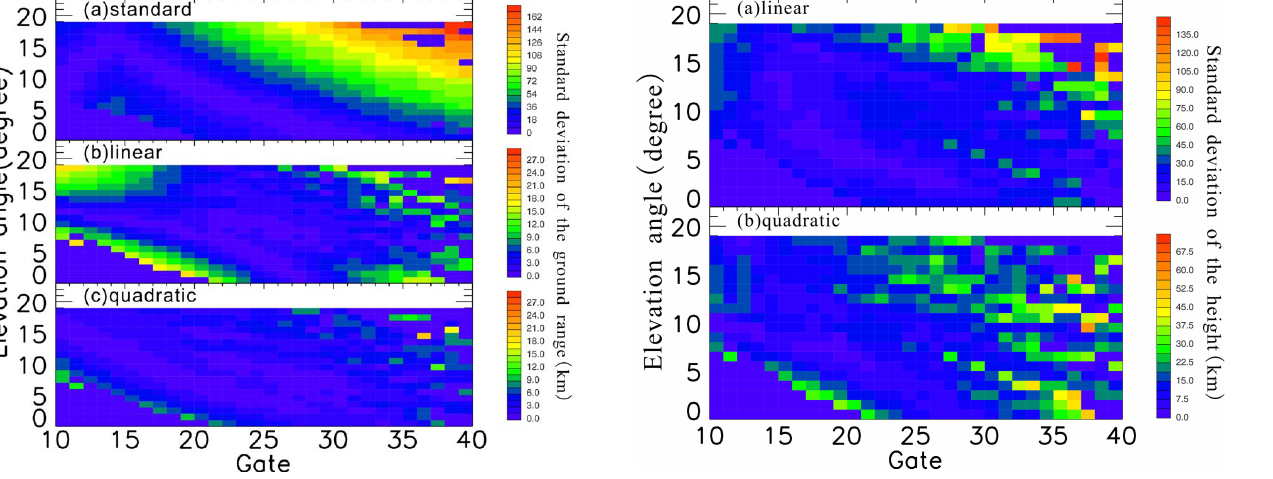
Fig. 9. Ground standard deviation of (a) the standard model of Su- perDARN, (b) the linear model and (c) the quadratic polynomial model determined by gate and elevation angle. The data set of 2009 is selected.